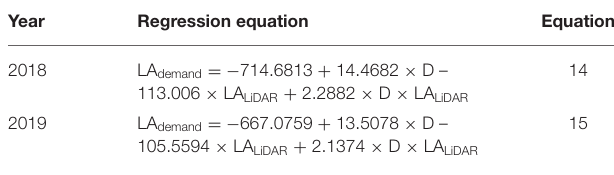
TABLE 2 | Regression equations of the relationship between the mean LA demand and the light detection and ranging (LiDAR)-measured leaf area (LA LiDAR ) for the estimation of the LA necessary to yield fruit of the target diameter (D) in 2018 and 2019.